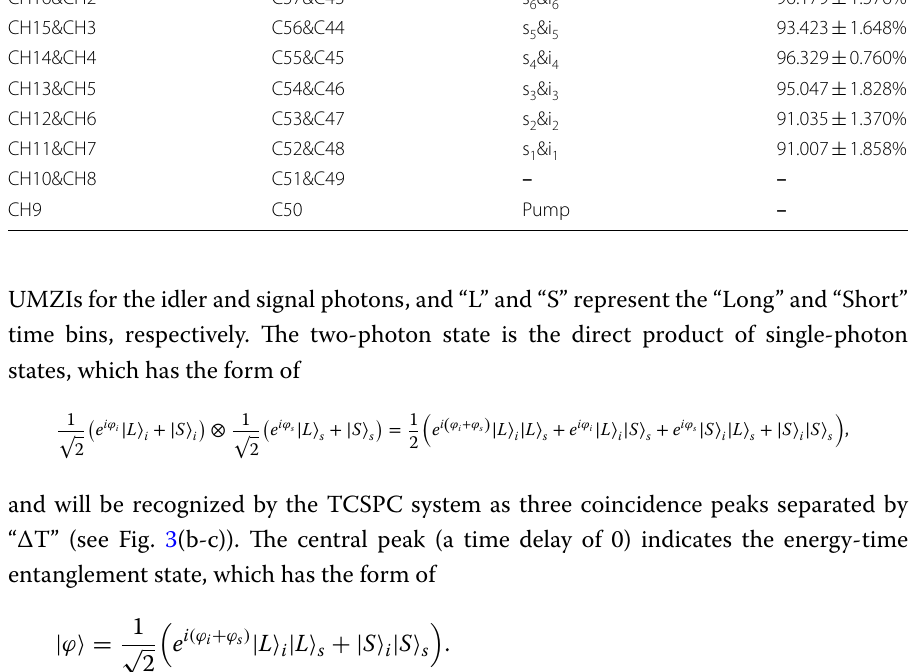
Table 1. All raw visibilities are over 90%, which proves that the integrated circuits have